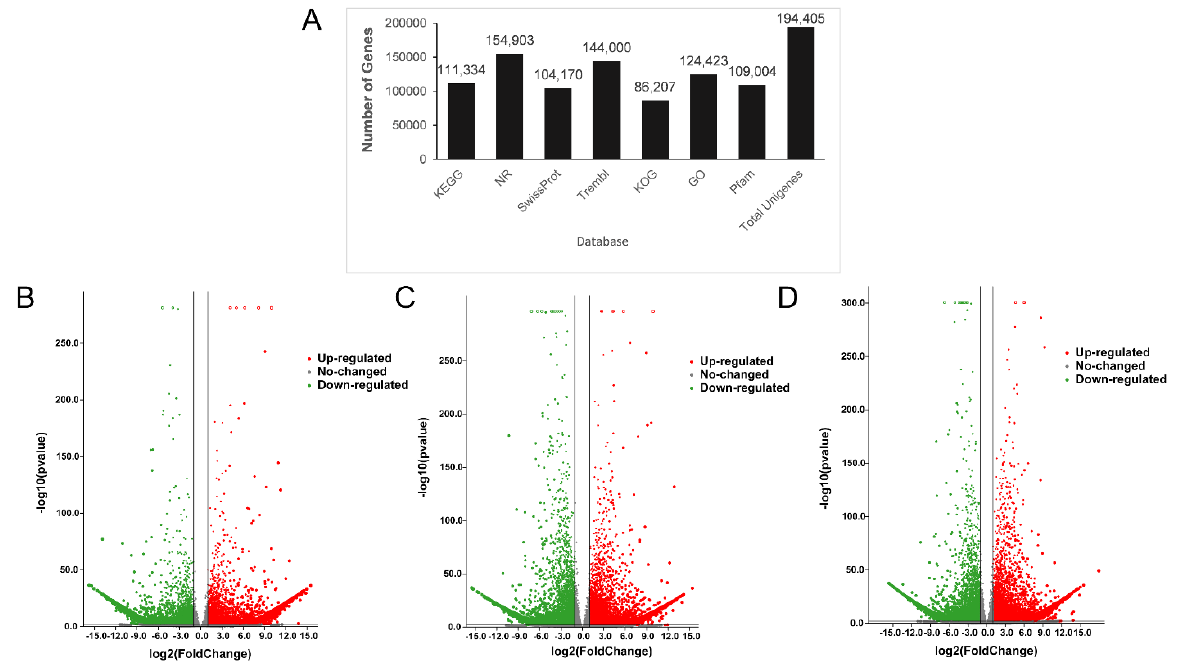
Figure 4. Identification of differential genes: ( A ) annotation by the seven databases; volcano plots of differential gene expression analysis: ( B ) GP vs. RP, ( C ) YP vs. GP, ( D ) YP vs. RP.